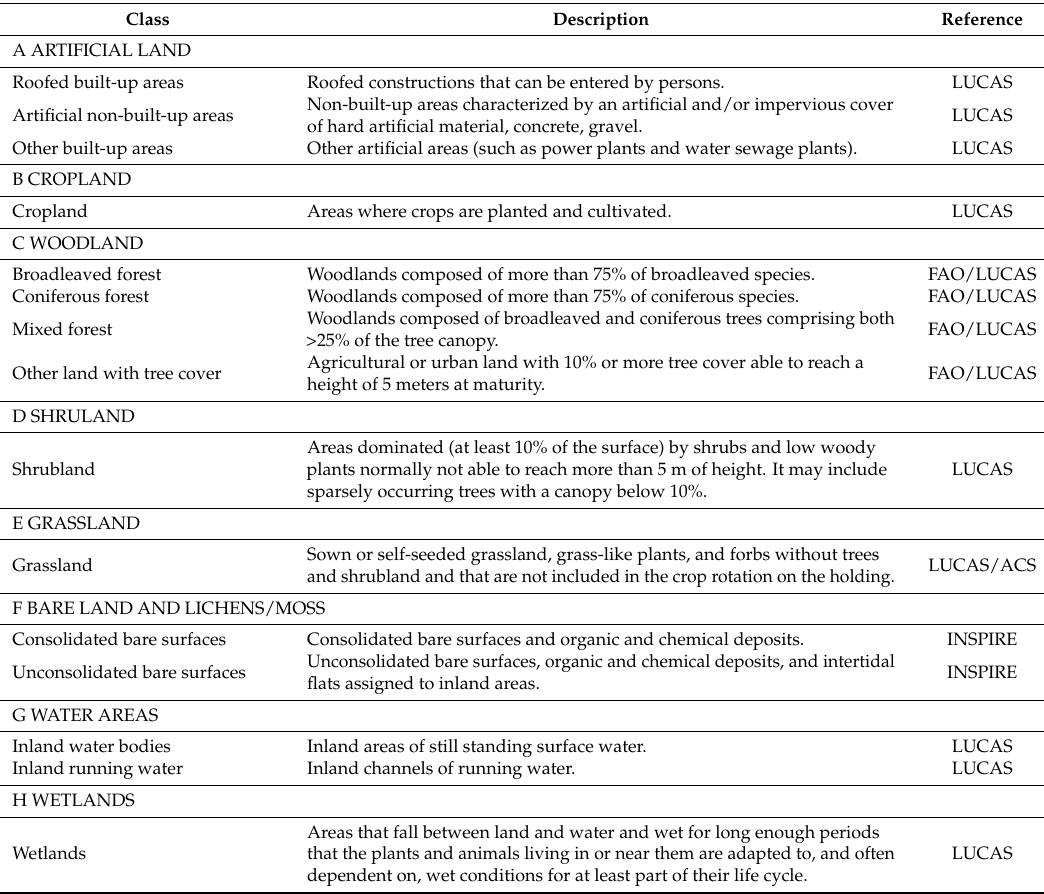
Table 1. Land cover classification system (main LUCAS categories are shown in capitals for guidance).